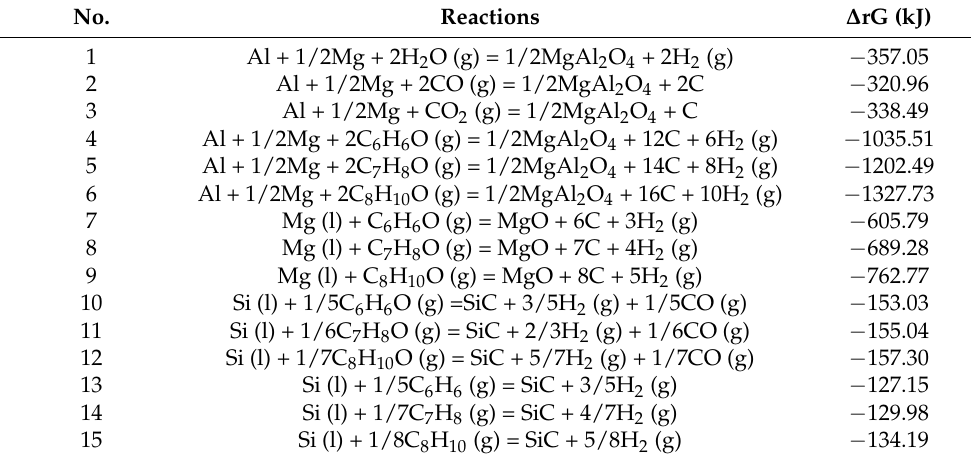
Table 2. Designed reactions and their Gibbs free energy change (800 ◦